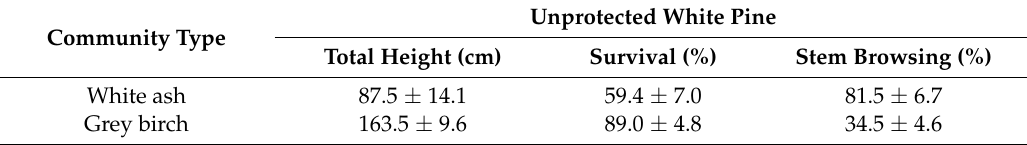
Table 4. Mean total height growth, survival rate and main stem browsing ( ± standard error) after 6 years for unprotected white pine in the two forest community types (N = 8 plots in the white ash community type and N = 17 plots in the Grey birch-balsam poplar-elm community type). All means are statistically different between community types at the α = 0.05 level following Student’s t -test.